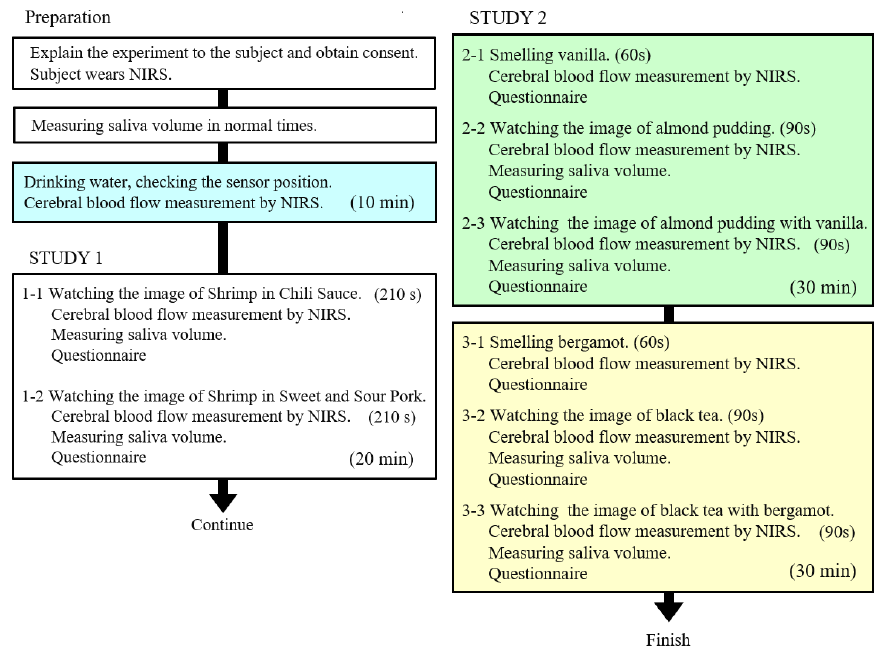
Figure 3. Experimental procedure for 12 subjects whose saliva volume and cerebral blood flow changes were measured simultaneously. (Apart from this experiment, an experiment was conducted on 10 subjects to measure only cerebral blood flow without simultaneously measuring saliva).